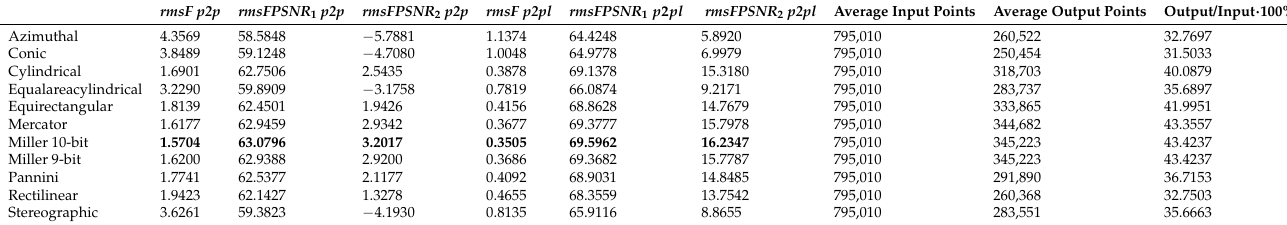
Table 4. Point-to-point (p2p) and point-to-plane (p2pl) objective measures rmsF , rmsFPSNR 1 and rmsFPSNR 2 , before Poisson reconstruction, using different projections with projection area of 1056 × 944 pixels (approximately 1,000,000), best values are bold; average input and output number of points and their ratio.